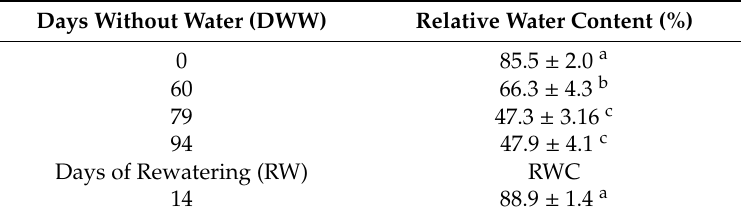
Table 1. Leaf relative water content (RWC) before (0 days) and during (60–94 days) water stress, and after the rewatering period of 14 day. Data are means ( n = 10) ±